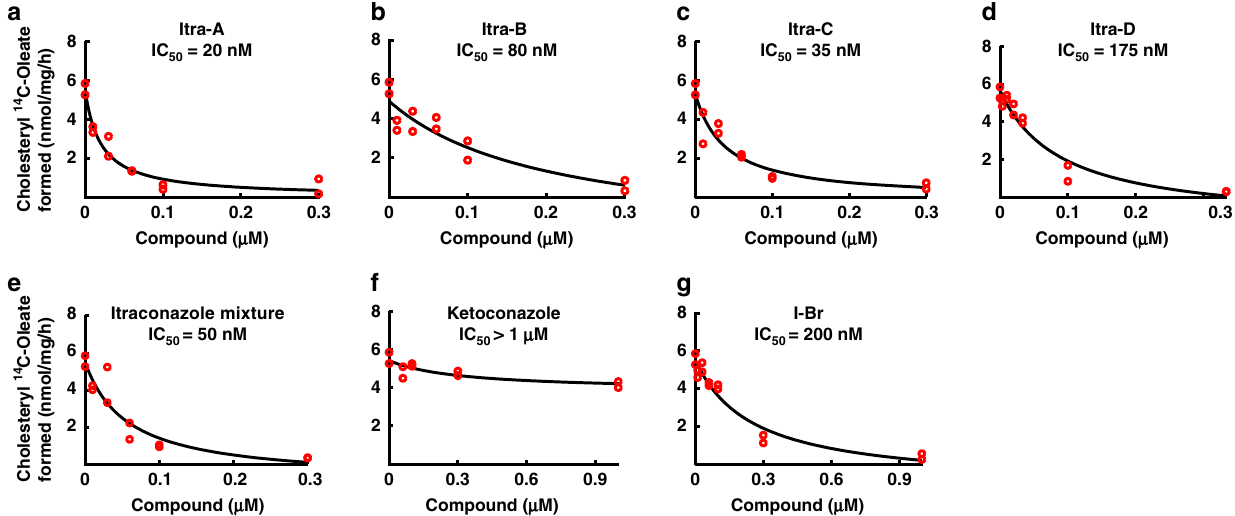
Fig. 2 ACAT activity of itraconazole and ketoconazole in CHO-7 cells. On day 0, CHO-7 cells were set up in medium A with 5% LPDS at 2.5 × 10 5 cells/ well in 6-well dish. On day 2, cells were switched to medium A with 5% LPDS containing 50 µ M sodium compactin and 50 µ M sodium mevalonate. On day 3 the cells received fresh medium B containing compactin and mevalonate with various concentration compounds in the presence of 10% FCS containing lipoproteins. After incubation for 4 h at 37 °C, each cell monolayer was pulse-labeled for 2 h with 0.1 mM sodium [ 14 C] oleate (5792 dpm/nmol). The cells were then harvested for measurement of their content of cholesteryl [ 14 C] oleate and [ 14 C] triglycerides, as described in Methods. The inhibitory constant (IC 50 ) values (denoting the concentration at which each compound inhibited cholesterol esteri fi cation by 50%) are indicated. Values for incorporation of [ 14 C] oleate into [ 14 C] triglycerides in cells treated with 0.3 μ M of all compounds ranged from 9.7 to 14.3 nmol/h per 1 mg protein. Itraconazole mixture, isomer A (Supplementary Fig. 2a), isomer B (Supplementary Fig. 2b) and isomer C (Supplementary Fig. 2c) were added at fi nal concentrations of 0.3 μ M. The isomer D (Supplementary Fig. 2d), I-Br and ketoconazole were added at fi nal concentrations of 1 μ M. The biological repeats are shown as individual values. Source data are provided as a Source Data fi